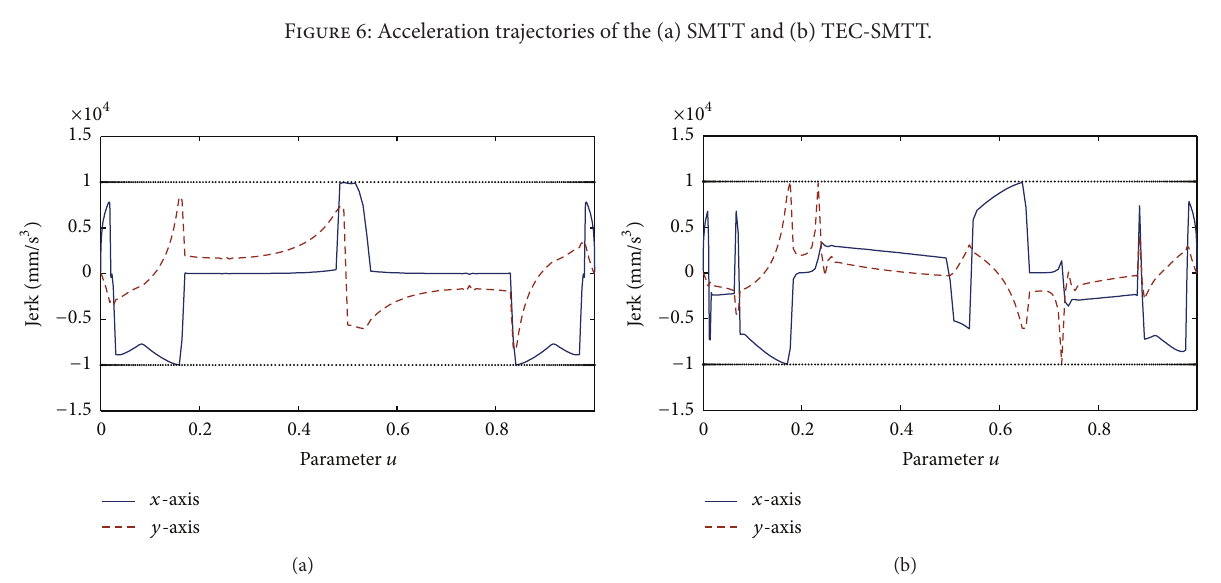
Figure 7: Jerk trajectories of the (a) SMTT and (b)